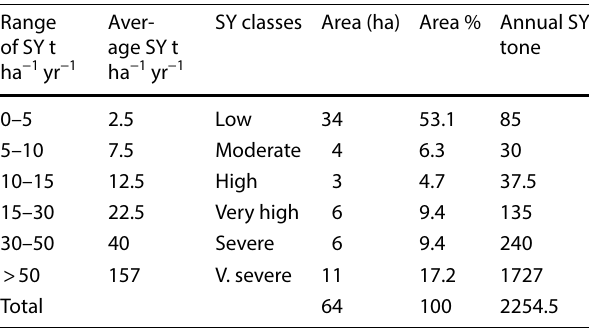
Table 8 Channel SDR value and the area